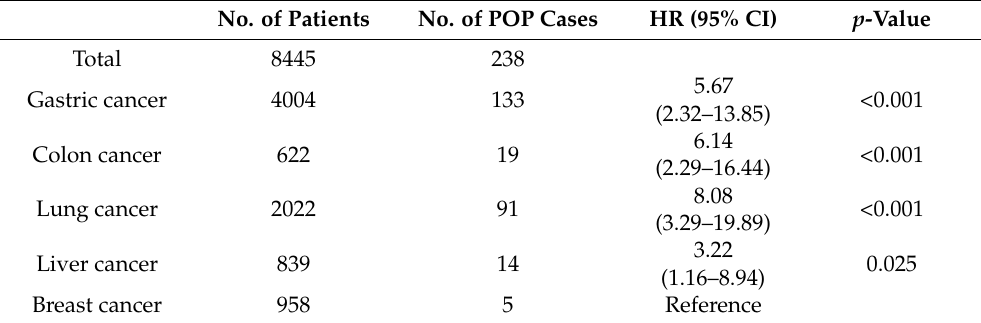
Table 2. Cumulative incidence of postoperative pneumonia in all patients according to cancer